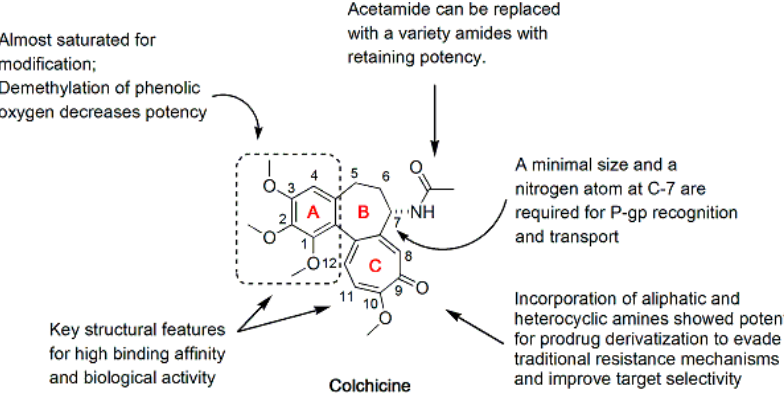
Figure 1. SAR of colchicine.